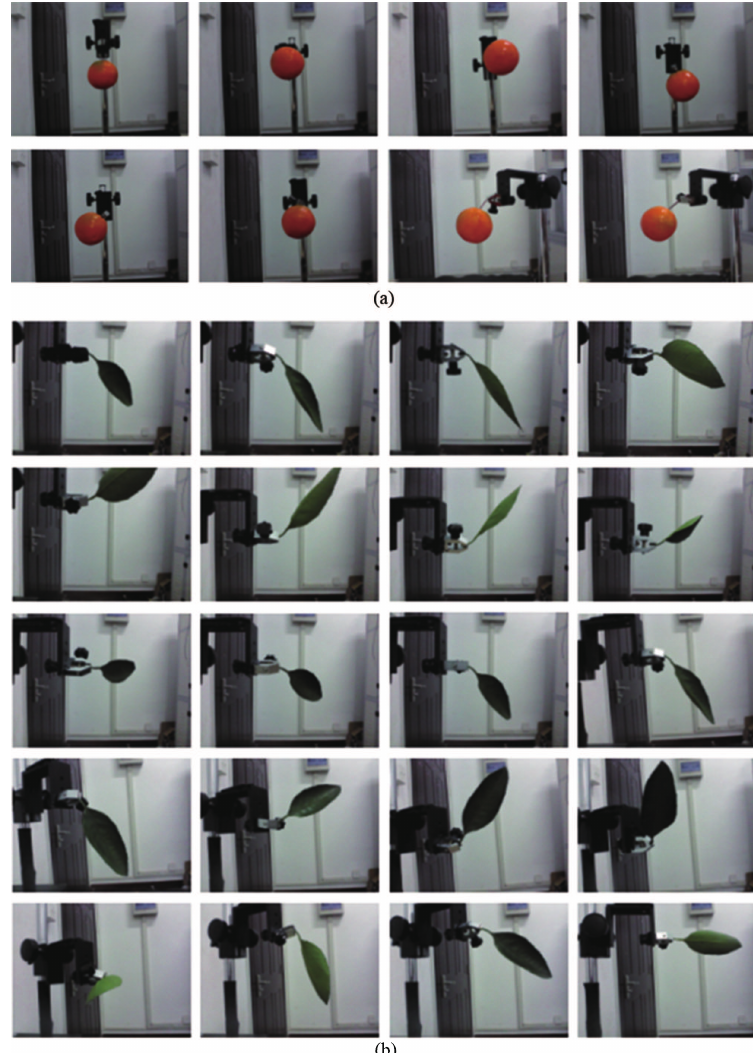
Figure 11. Position-postures of the isolated objects: ( a ) eight kinds of fruit position-postures; ( b ) twenty kinds of leaf